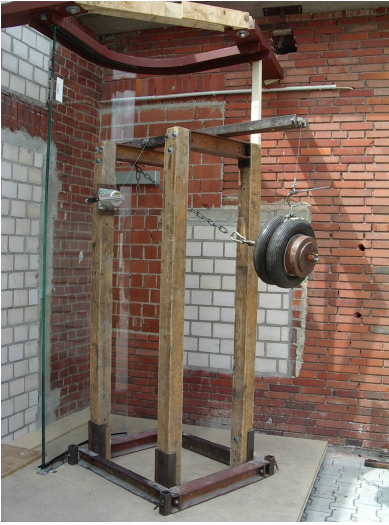
Figure 6a: Construction of pendulum impact test. Figure 6b: Collapsed glass